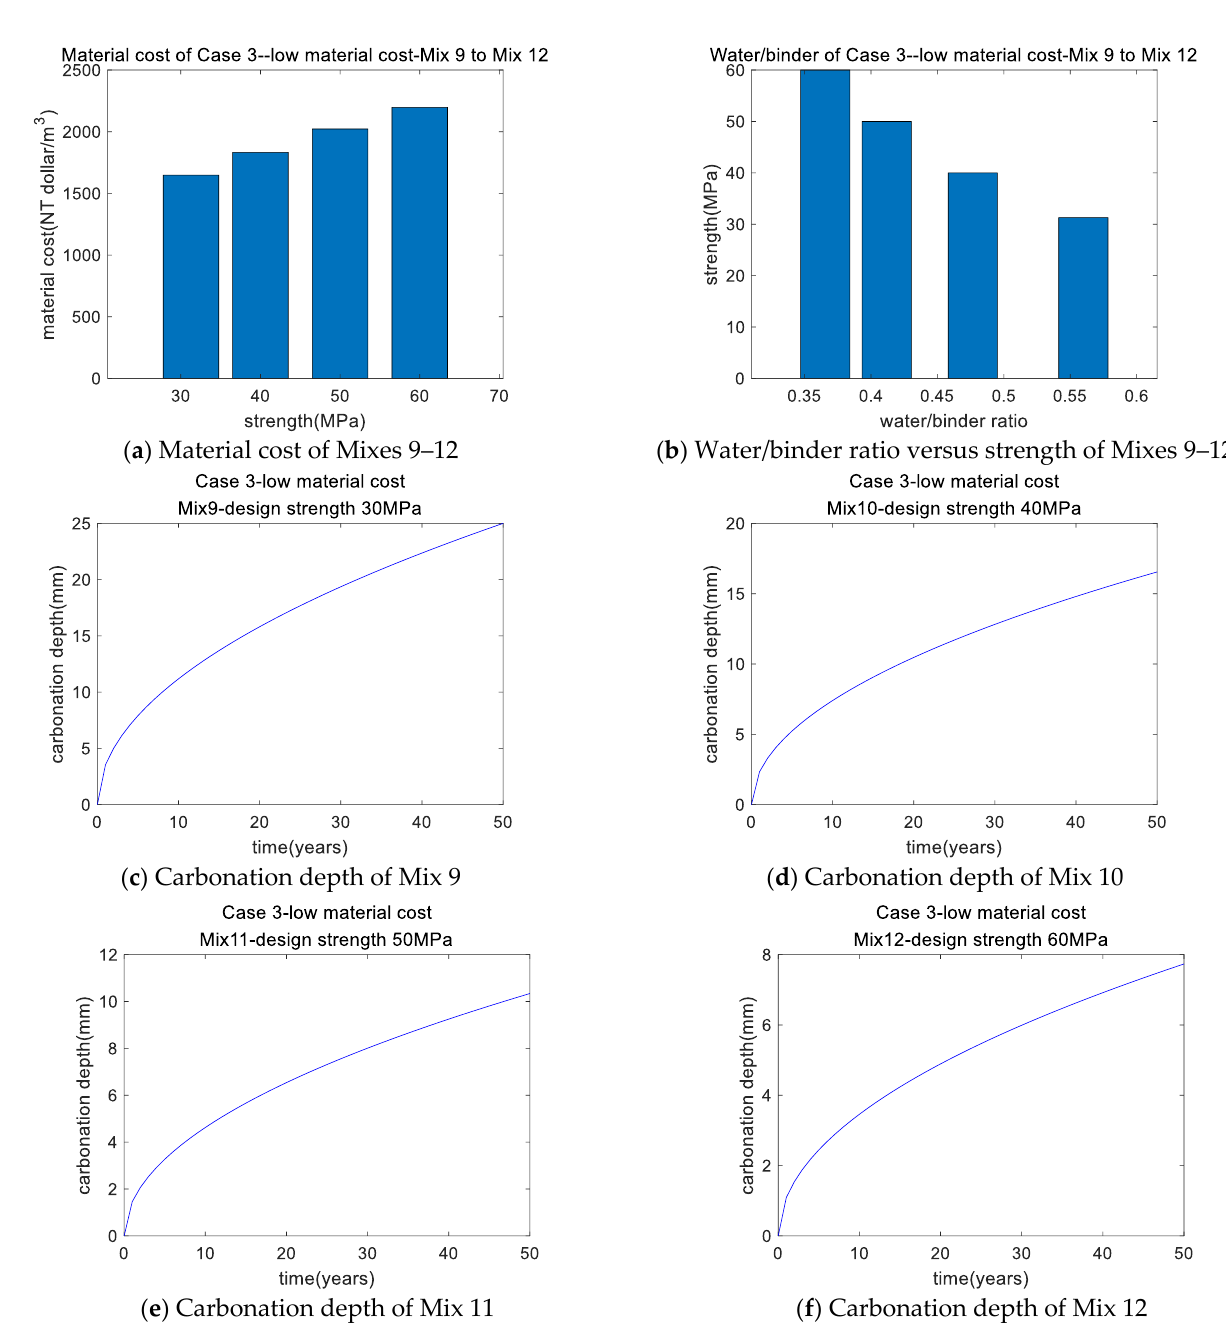
Figure 4. Performance of Case 3: Mixes 9 – 12 (low material cost).